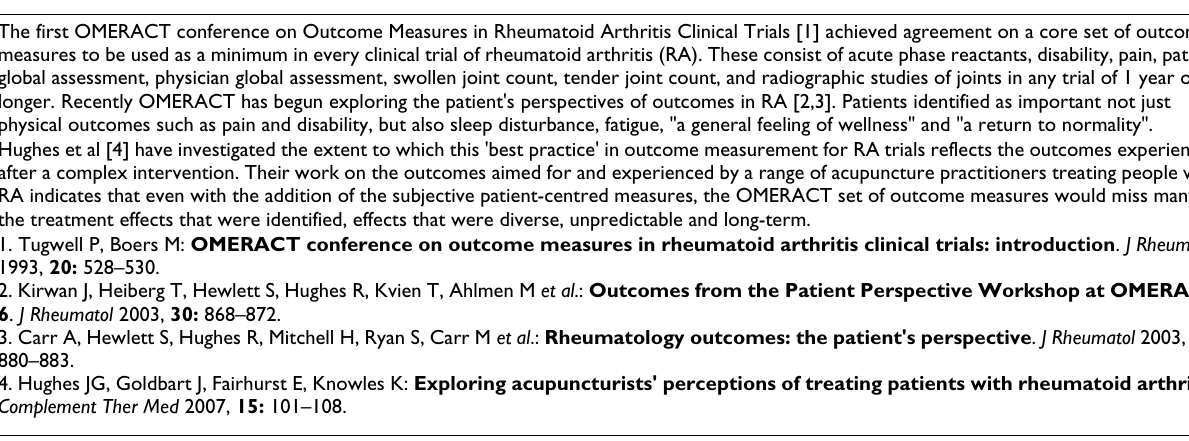
Table 1: OMERACT – best practice in disease-focused pharmaceutical trials The first OMERACT conference on Outcome Measures in Rheumatoid Arthritis Clinical Trials [1] achieved agreement on a core set of outcomes measures to be used as a minimum in every clinical trial of rheumatoid arthritis (RA). These consist of acute phase reactants, disability, pain, patient global assessment, physician global assessment, swollen joint count, tender joint count, and radiographic studies of joints in any trial of 1 year or longer. Recently OMERACT has begun exploring the patient's perspectives of outcomes in RA [2,3]. Patients identified as important not just physical outcomes such as pain and disability, but also sleep disturbance, fatigue, "a general feeling of wellness" and "a return to normality". Hughes et al [4] have investigated the extent to which this 'best practice' in outcome measurement for RA trials reflects the outcomes experienced after a complex intervention. Their work on the outcomes aimed for and experienced by a range of acupuncture practitioners treating people with RA indicates that even with the addition of the subjective patient-centred measures, the OMERACT set of outcome measures would miss many of the treatment effects that were identified, effects that were diverse, unpredictable and